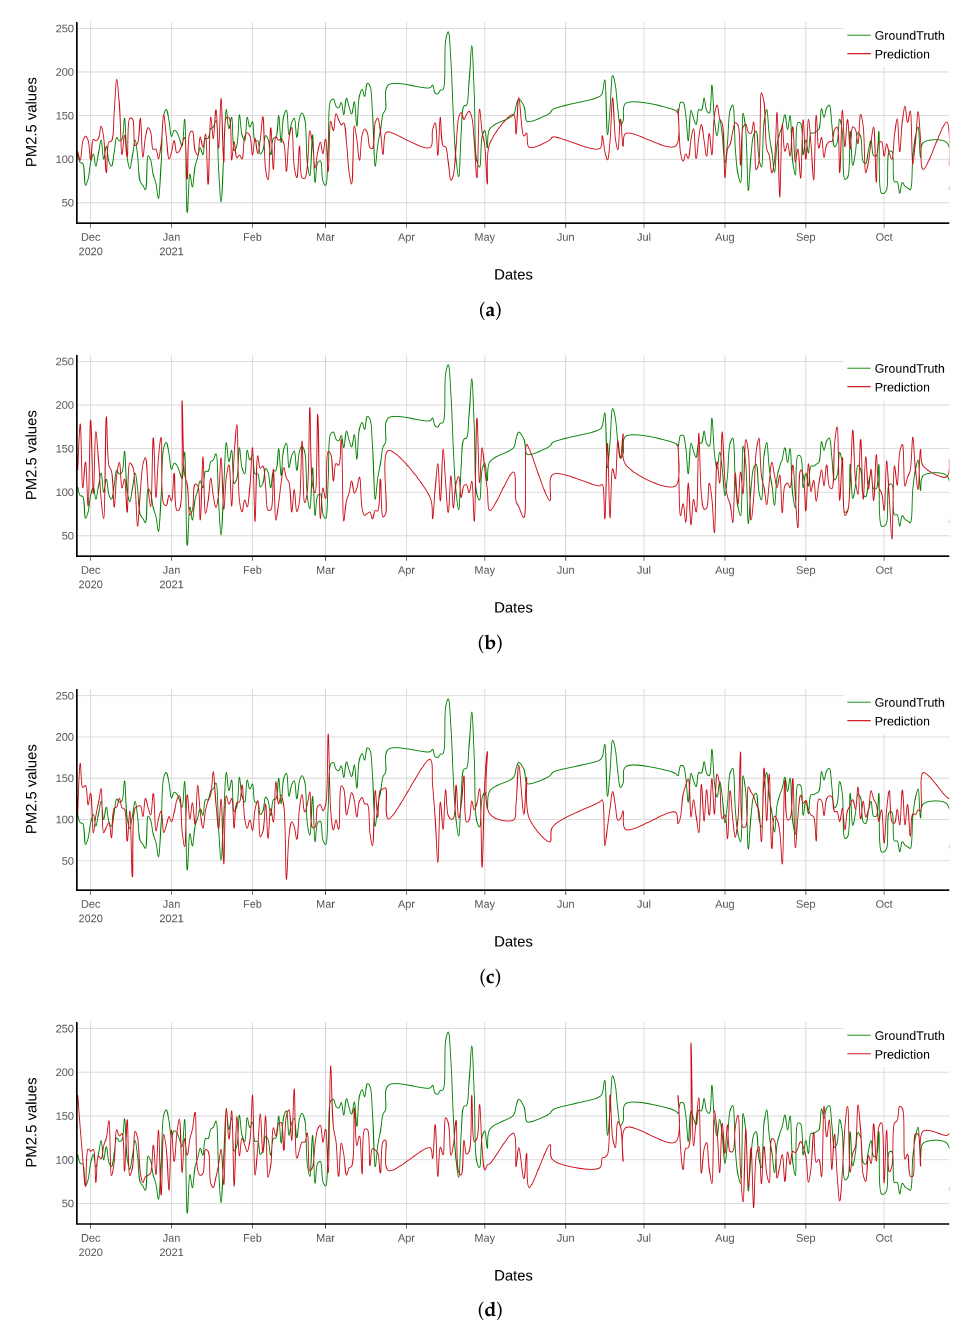
Figure 7. Wuhan PM2.5 predictions. ( a ) PM2.5 predictions on the testing set using Informer; ( b ) PM2.5 predictions on the testing set using InformerStack; ( c ) PM2.5 predictions on the testing set using ResInformer; ( d ) PM2.5 predictions on the testing set using